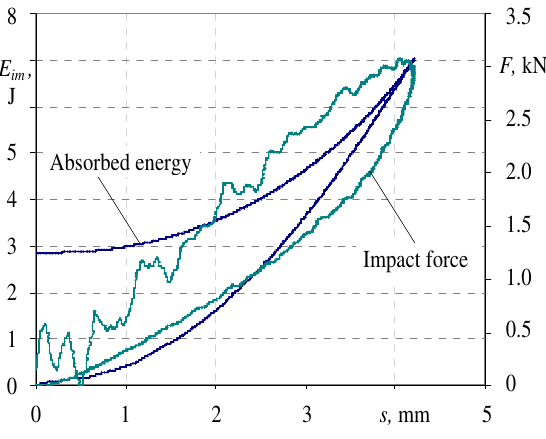
Fig 3. Damaged area, plotted against the impact energy J Fig 2. Absorbed energy and impact force plotted against The damaged areas, D a , obtained by visual impactor displacement by impact energy of 6 J inspection of the specimens with woven fabrics and multiaxial non-crimp fabric reinforcement, are plotted as a function of the incident energy in figure 3 [6]. The increase in delaminated area with increasing impact energy is lower in the case of woven-fabric laminated specimens. These results agree with previous